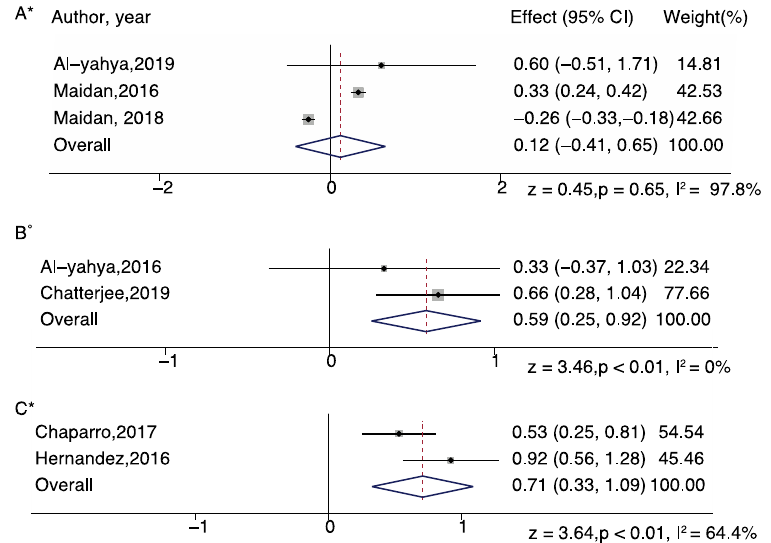
Figure 6. Dual task brain activation differences while doing serial subtraction (Parkinson’s disease—( A ) and stroke—( B )), letter generation tasks (multiple sclerosis—( C )) in adults with neurological diseases. Note: ° represents Fixed plot meta-analysis, * represents Random plot meta-analysis. tasks ( n = 15, p = 0.095, Figure 7), nor in adults with neurological conditions across all tasks ( n = 7, p = 0.233).